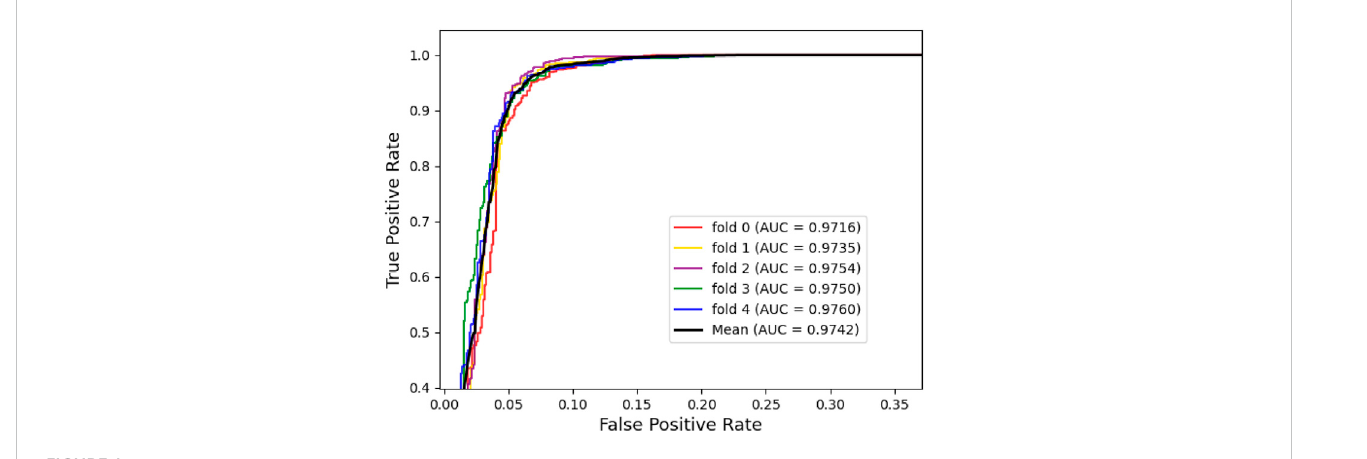
FIGURE 1 ROC curves plot for LPIH2V.